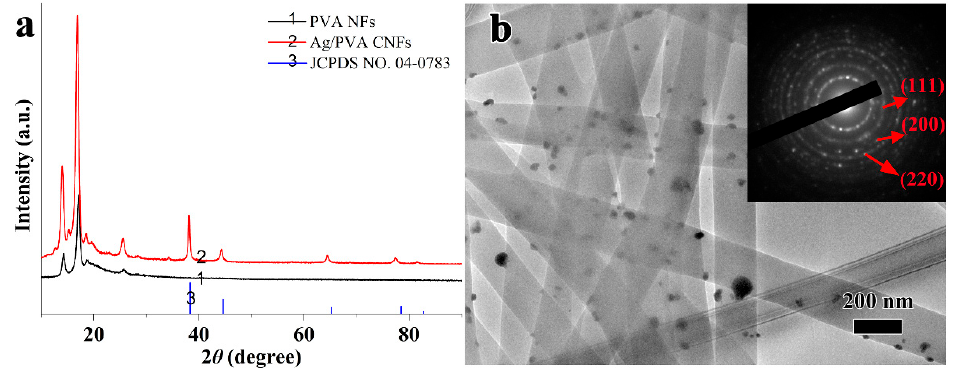
Figure 4. ( a ) XRD patterns of PVA NFs and Ag / PVA CNFs, ( b ) TEM image of Ag / PVA CNFs prepared with AgNO 3 concentration at 0.066 mol/L, the inset is the SAED patterns of Ag NPs.